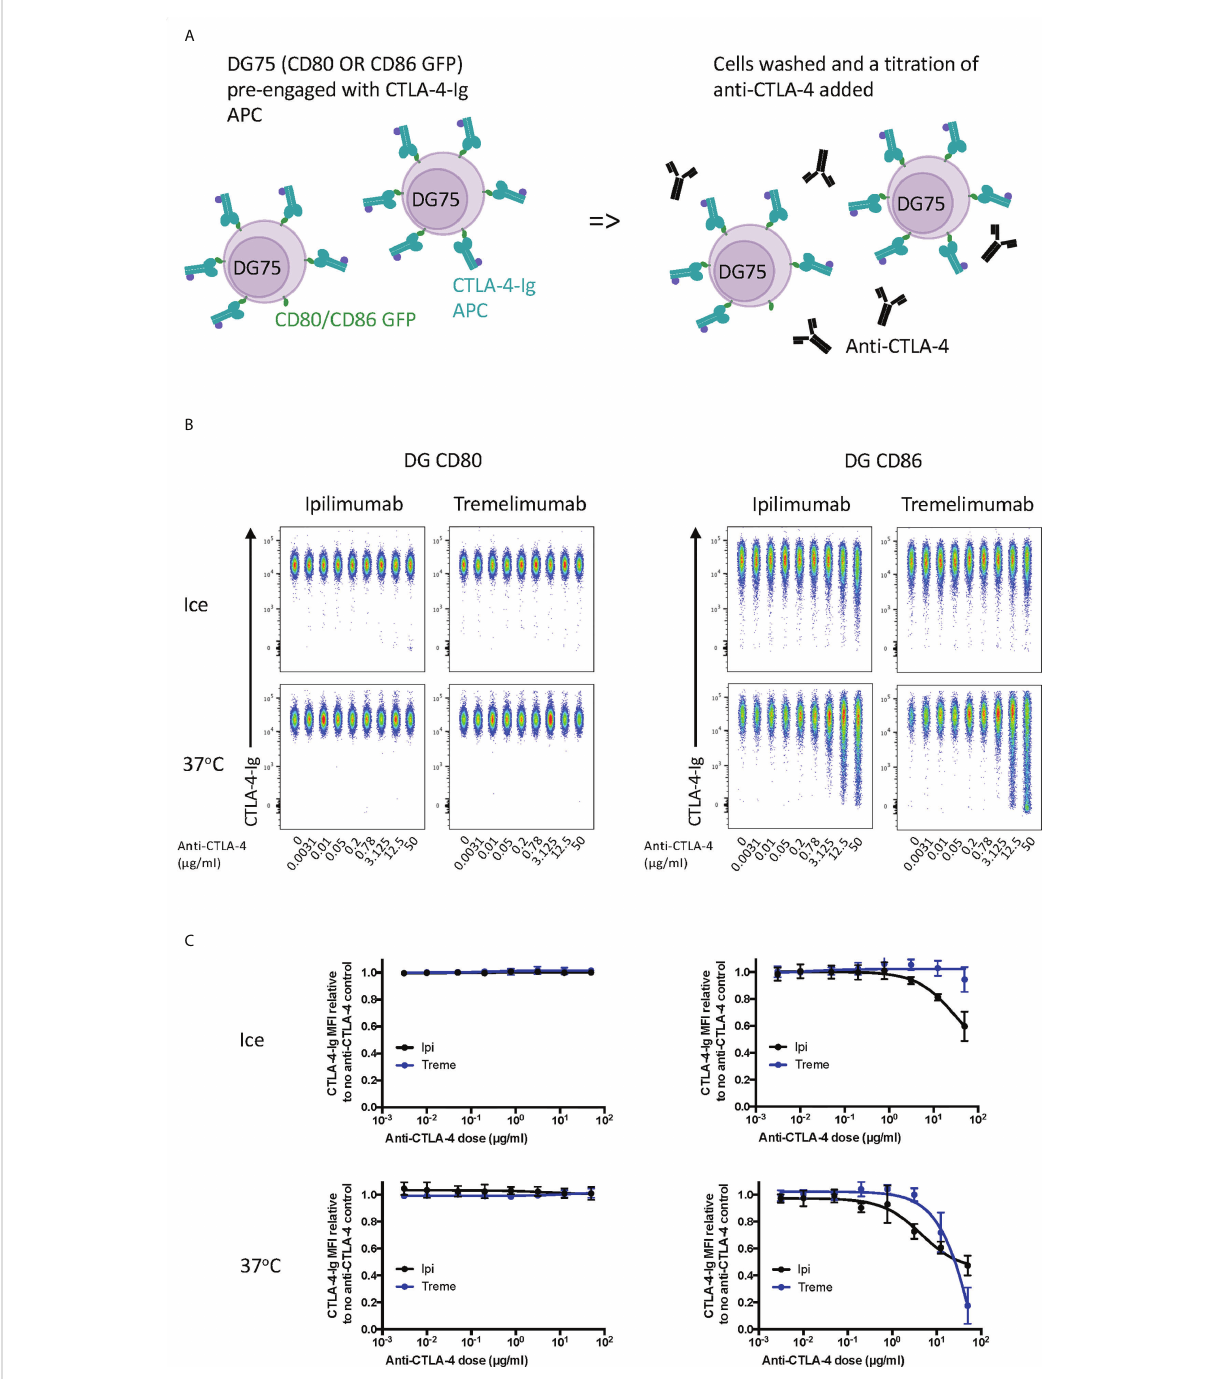
FIGURE 3 Ipilimumab and Tremelimumab are unable to displace pre-engaged CTLA-4-Ig from cell bound CD80 or CD86. (A) Schematic of experimental set-up. DG75 B cells expressing either CD80 or CD86-GFP were pre-incubated on ice with a fi xed dose (2µg/ml) of soluble APC conjugated Abatacept to pre-engage soluble CTLA-4 with ligand. Cells were washed, treated with a titration of soluble anti-CTLA-4 Abs and incubated on ice or at 37°C. Cells were washed and analysed for Abatacept-ligand engagement by fl ow cytometry. All reagents/cells were chilled on ice before use. (B) Concatenated FACS plots show Abatacept-ligand binding at different doses of anti-CTLA-4 Abs when incubated on ice or when incubated at 37°C. (C) Dose response curves for ipilimumab (Black line) and tremelimumab (Blue line) presented as MFI CTLA-4-Ig binding from data shown in (B) Data presented are mean +/- SD from 3-6 independent experiments. Data for ipilimumab and tremelimumab were acquired in separate 96-well plates